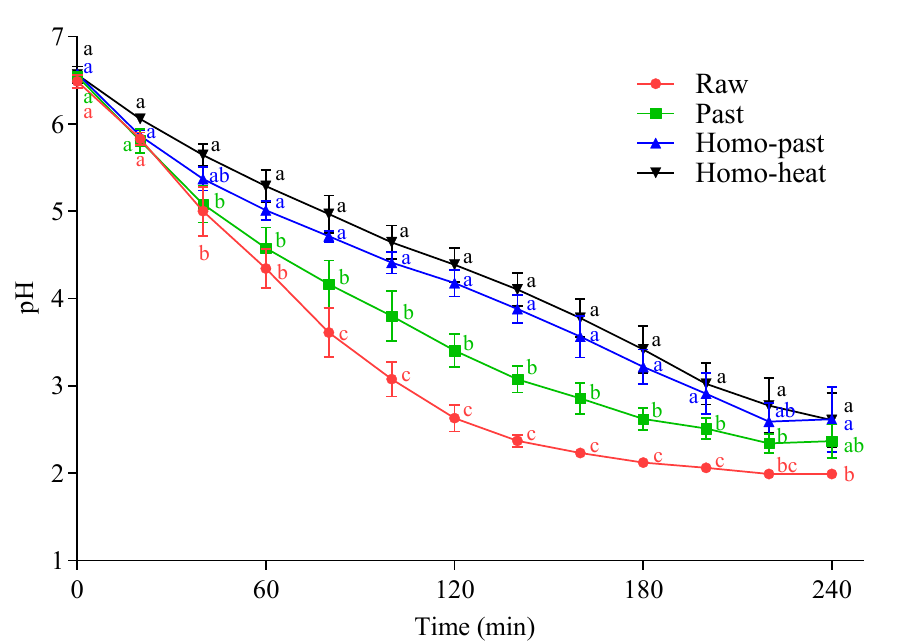
Figure 1. pH changes during the in vitro gastric digestion of differently processed sheep milks: ● , raw milk; ■ , pasteurized (Past) milk; ▲ , homogenized and pasteurized (Homo–past) milk; ▼ , homogenized and heated (Homo–heat) milk. Different lowercase letters indicate significant difference ( p < 0.05). Error bars represent standard deviations.